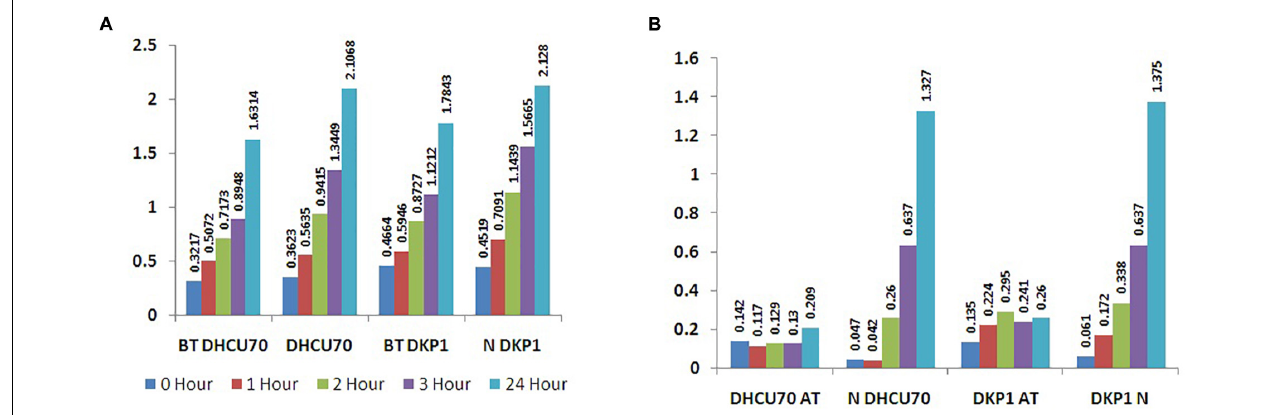
FIGURE 5 | (A) Bile tolerance of L. plantarum strains DHCU70 and DKP1; (B) Acid tolerance of L. plantarum strains DHCU70 and DKP1. TABLE 4 | Bile and acid tolerance of L. plantarum isolates DHCU70 and DKP1. Treatments and